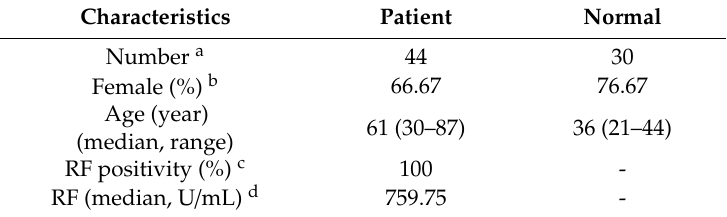
Table 4. Serum aliquots were frozen immediately after collection and stored at − 80 Table 4. Clinical characteristics of the participant serum samples used in this